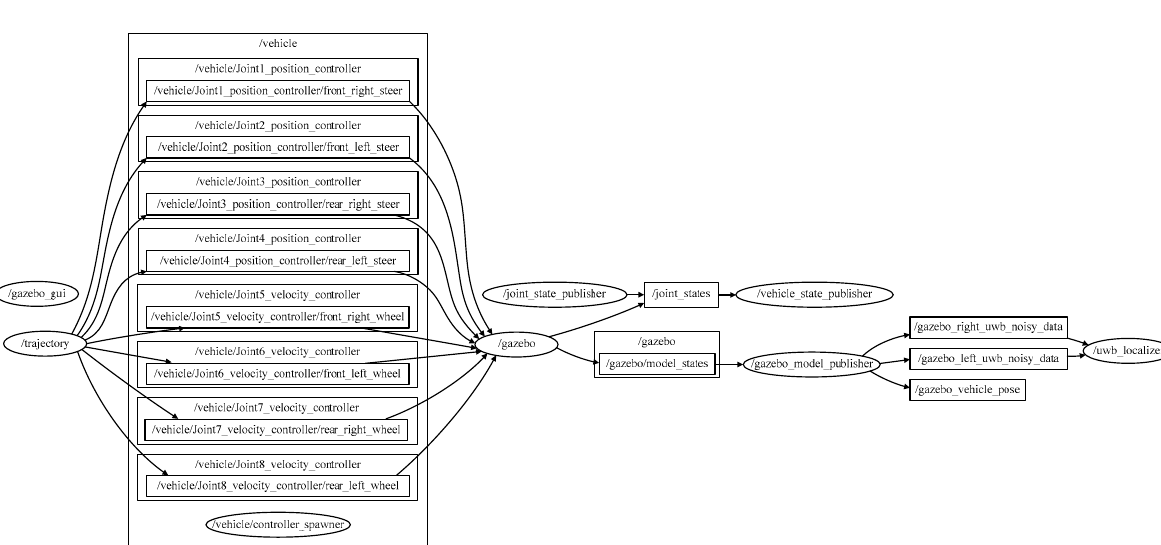
Figure 5. Link and joints relationship of simulation model.